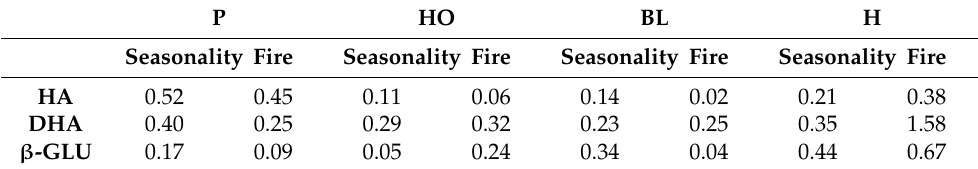
The CVs calculated for DHA highlighted the widest variability for seasonality in soils covered by P and for fire in soils covered by H (Table 4). The CVs for DHA were wider for seasonality than for fire only under P (Table 4); they were similar for seasonality and fire under HO and BL (Table 4); finally, they were wider for fire under H (Table 3). The CVs calculated for β -GLU showed the widest variability both for seasonality and for fire in soils covered by H (Table 4); they were wider for seasonality than for fire in soils covered by P and BL (Table 4); conversely, they were wider for fire under HO (Table 4).